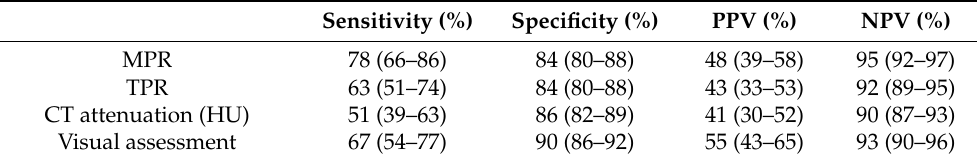
Table 2. Diagnostic accuracy of MPR, TPR, endocardial CT attenuation, and visual assessment for detection of myocardial perfusion abnormality.